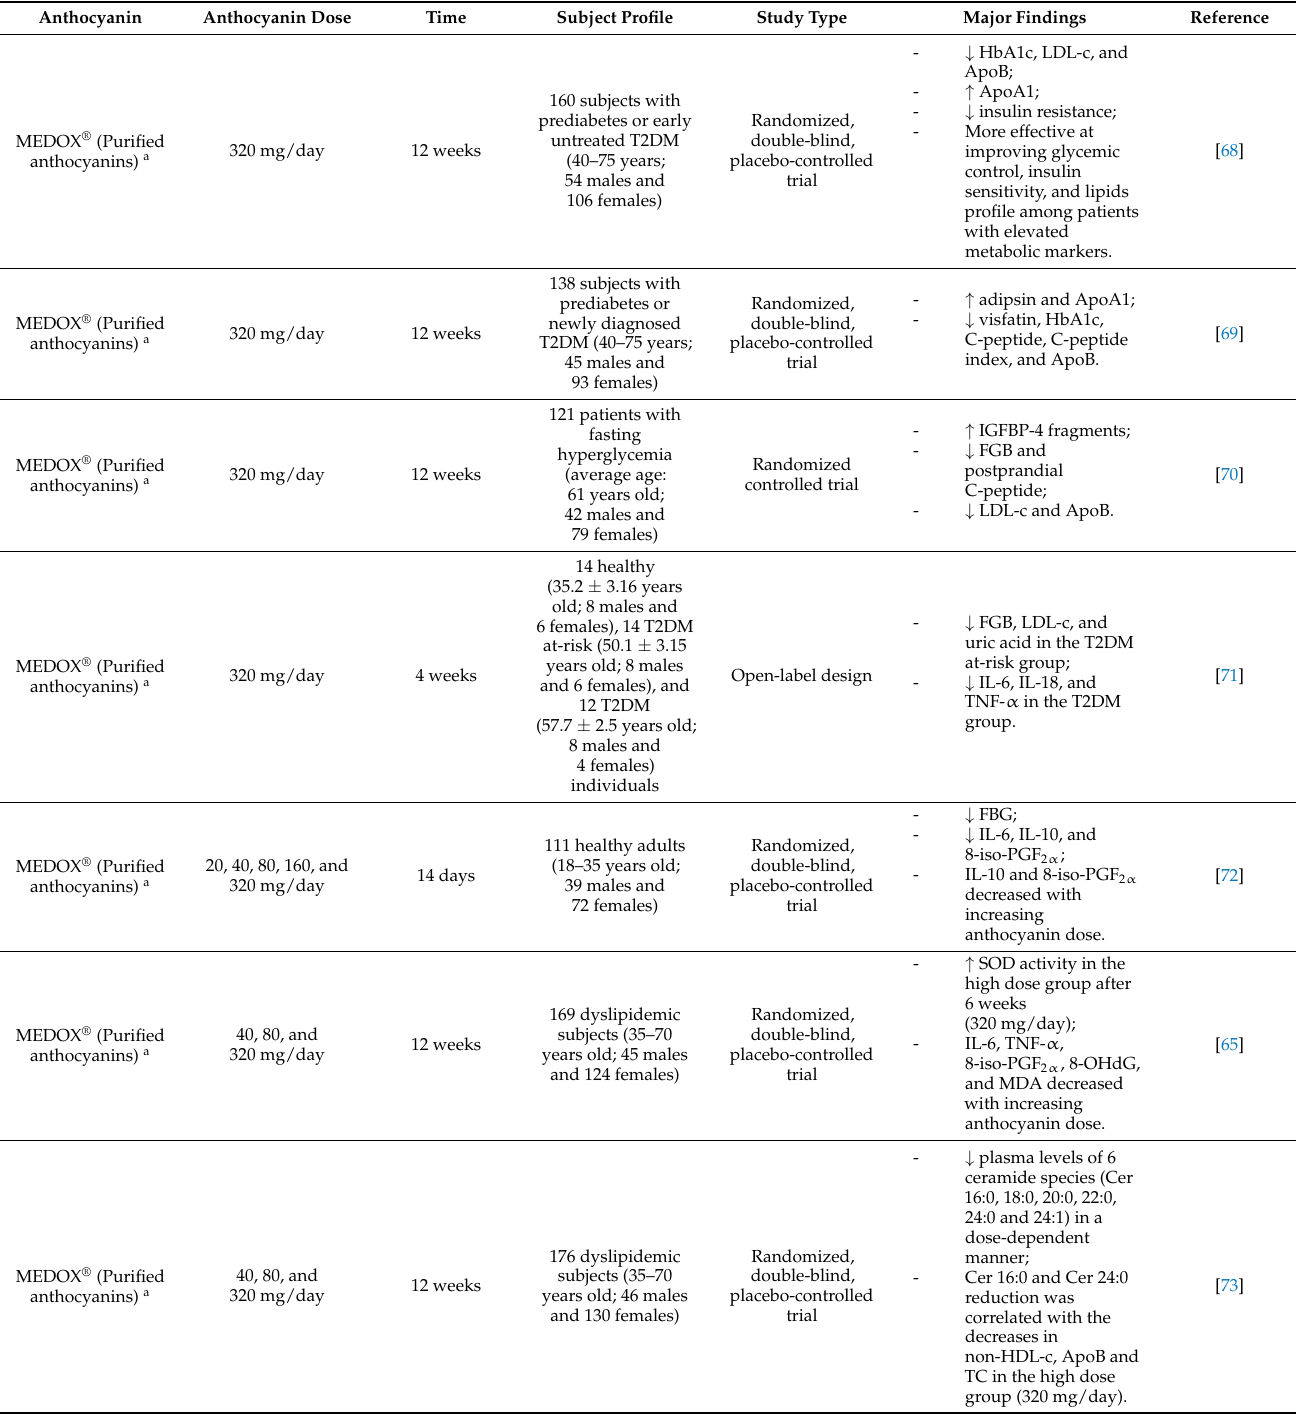
Table 1. A summary of human trials showing the potential health beneficial effects of anthocyanins.